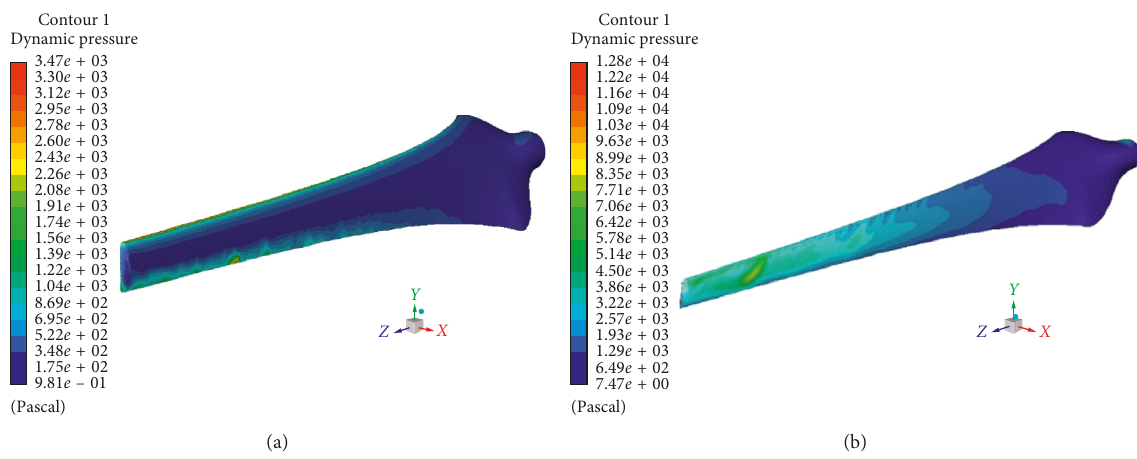
Figure 11: Pressure contours over the blade surface. (a). Contour pressure for 12m/s . (b). Contour pressure for 40 m/s.